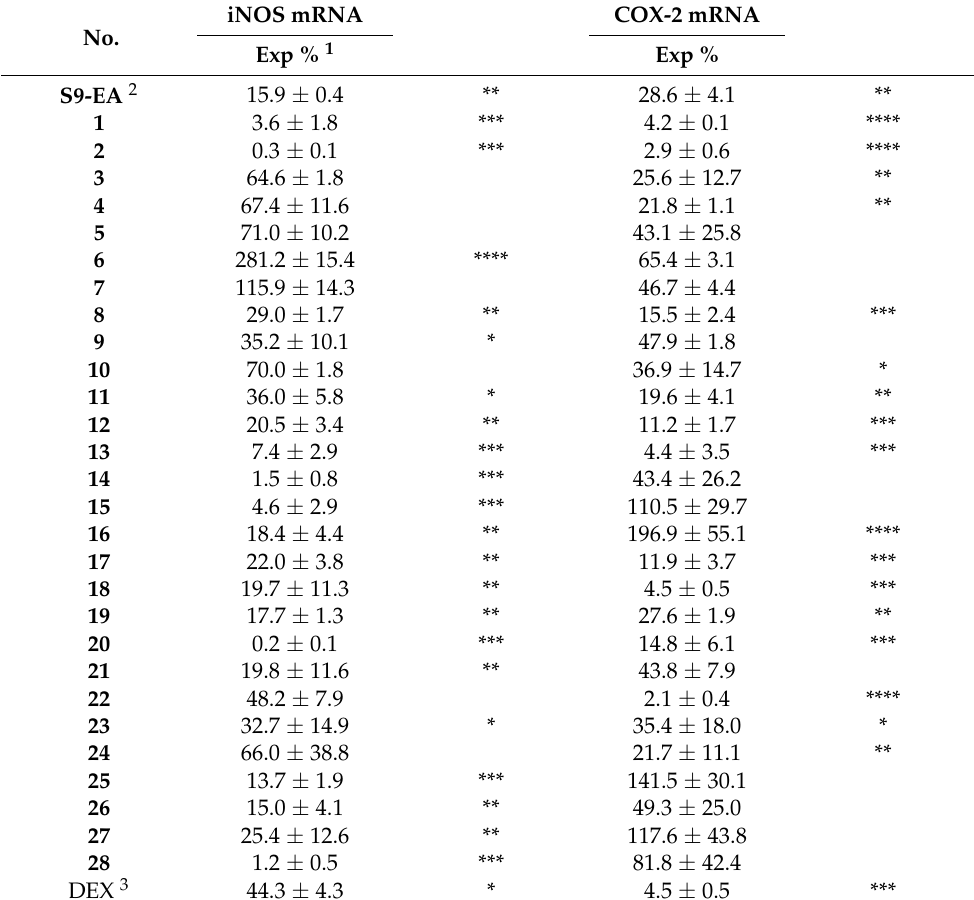
Table 9. Inhibitory effects of compounds 1 – 28 on iNOS and COX-2 mRNA expression in LPS-induced dendritic cells.